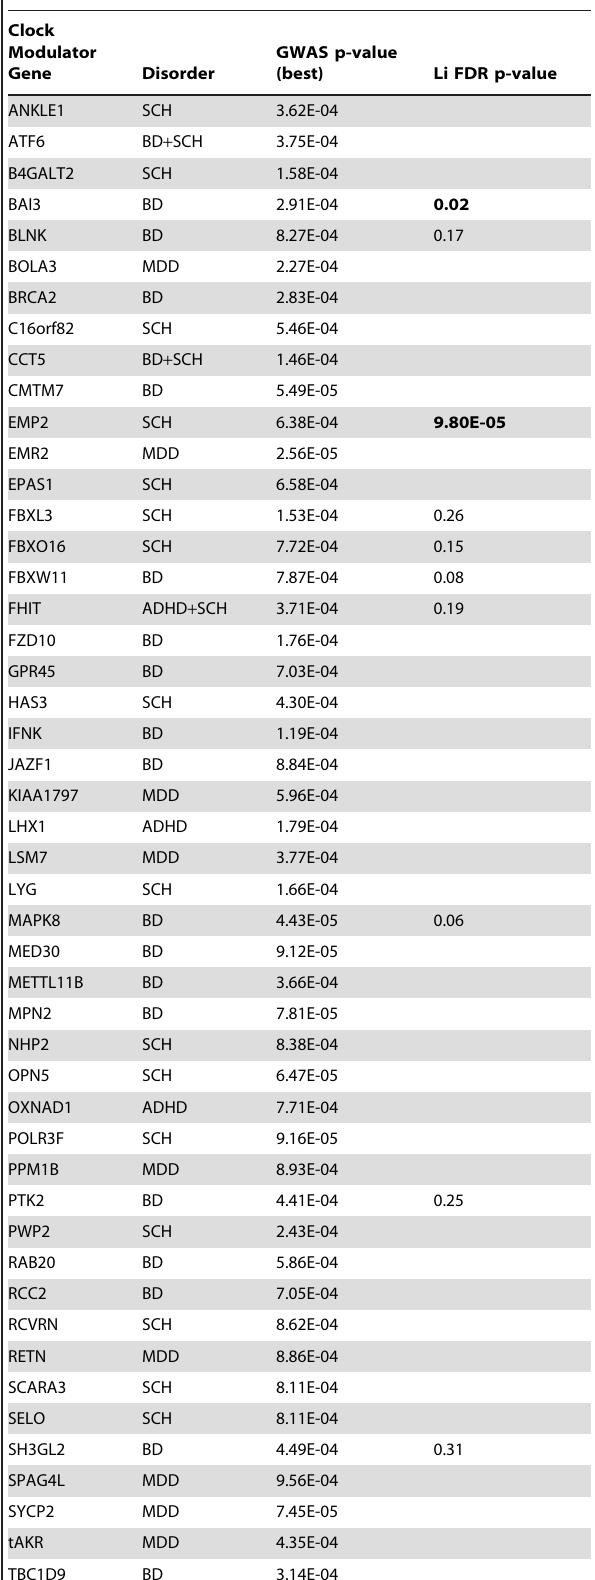
Table 3. BD-spectrum associated clock modulator genes.